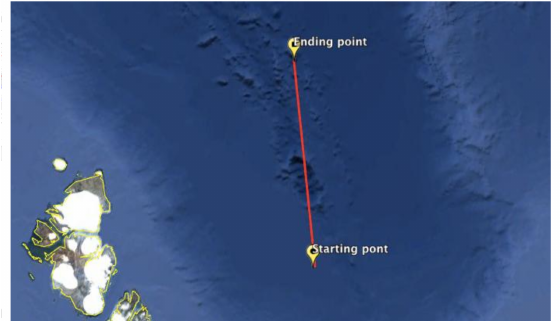
Figure 7. The sketch of the planned